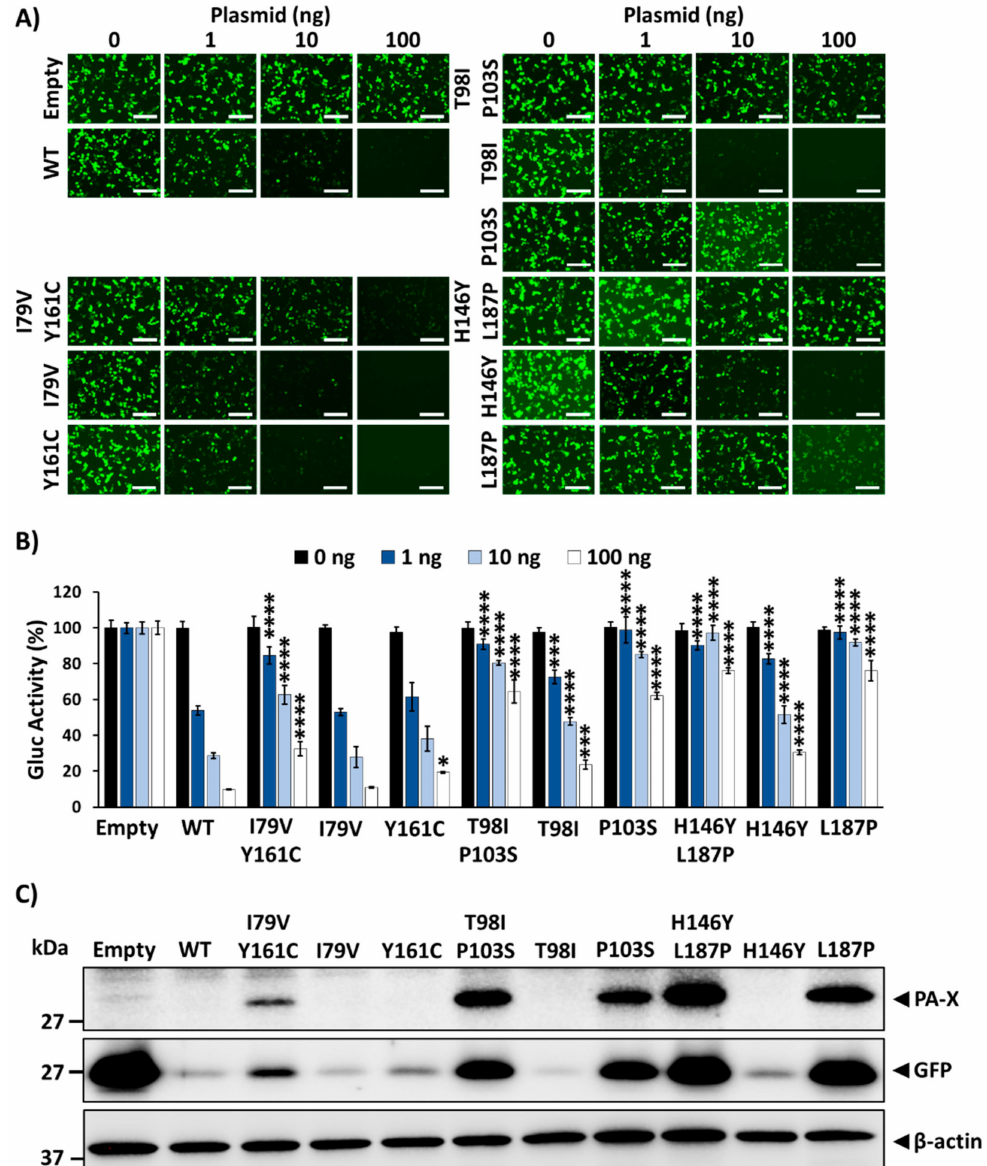
Figure 5. Effect of 1918 PA-X amino acid changes in inhibition of host gene expression: HEK293T cells were co-transfected with increasing concentrations (0, 1, 10, or 100 ng/well) of pCAGGS expression plasmids encoding 1918 PA-X single or double mutants fused to an HA epitope tag, and 250 ng of pCAGGS-Gluc and -GFP plasmids. Empty and 1918 WT pCAGGS plasmids were included as controls. At 24 h p.t., GFP was observed under a fluorescence microscope ( A ), and Gluc activity was quantified using cell culture supernatants ( B ). Gluc activity was normalized to the empty plasmid control transfected cells (100%). * p < 0.05; *** p < 0.0005; **** p < 0.0001; (PA-X WT versus PA-X mutants for each amount of plasmid) using one-way ANOVA and Dunnett’s test for multiple comparison correction. PA-X and GFP expression levels in cell lysates from the cells transfected with 100 ng/well of pCAGGS expression plasmids encoding the 1918 PA-X mutants were analyzed by Western blot using anti-HA or anti-GFP PAbs, respectively ( C ). β -actin was used as a loading control. Results are the means and SDs of triplicates. Data are representative of three separate experiments. Magnification 20 × , scale bar, 100 µ